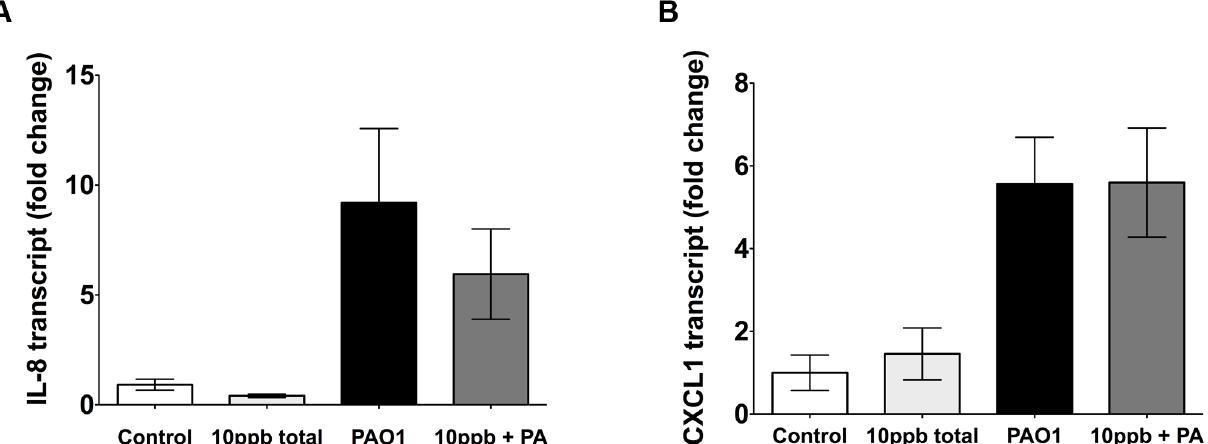
Fig 8. Exposure to mixtures of arsenic species does not alter cytokine mRNA. A mixture of arsenic (10 ppb: 2.5 ppb As III , 2.5 ppb MMA III and 5 ppb DMA V ) had no effect on (A) IL-8 or (B) CXCL1 mRNA. Thus, the observed reductions in IL-8 and CXCL1 cytokine levels induced by the mixture of arsenic species were not related to decreased mRNA levels. n =